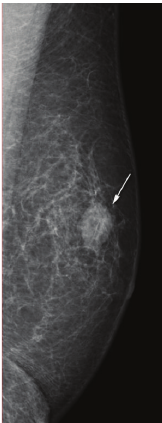
Figure 1: Myofibroblastoma of the breast of an 80-year-old man. A left, mediolateral oblique mammogram revealed a well-defined, moderate density mass (arrows) in the upper inner quadrant of the left breast.